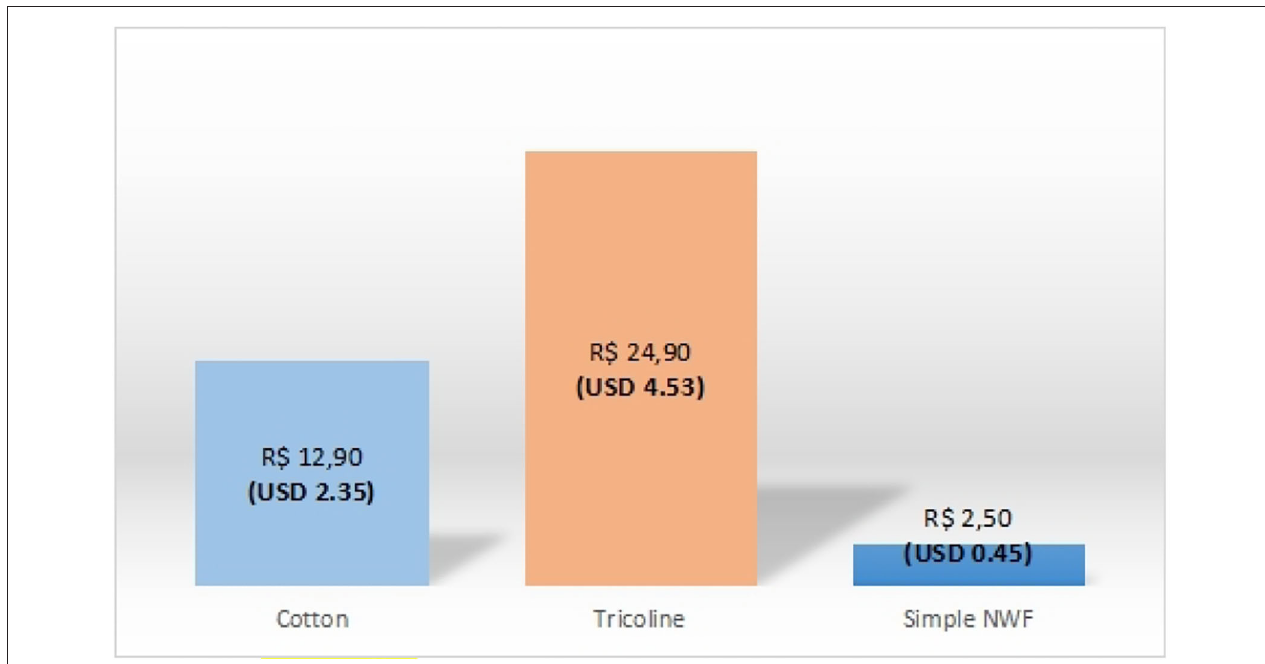
FIGURE 4 | Average prices of fabrics used do make reusable